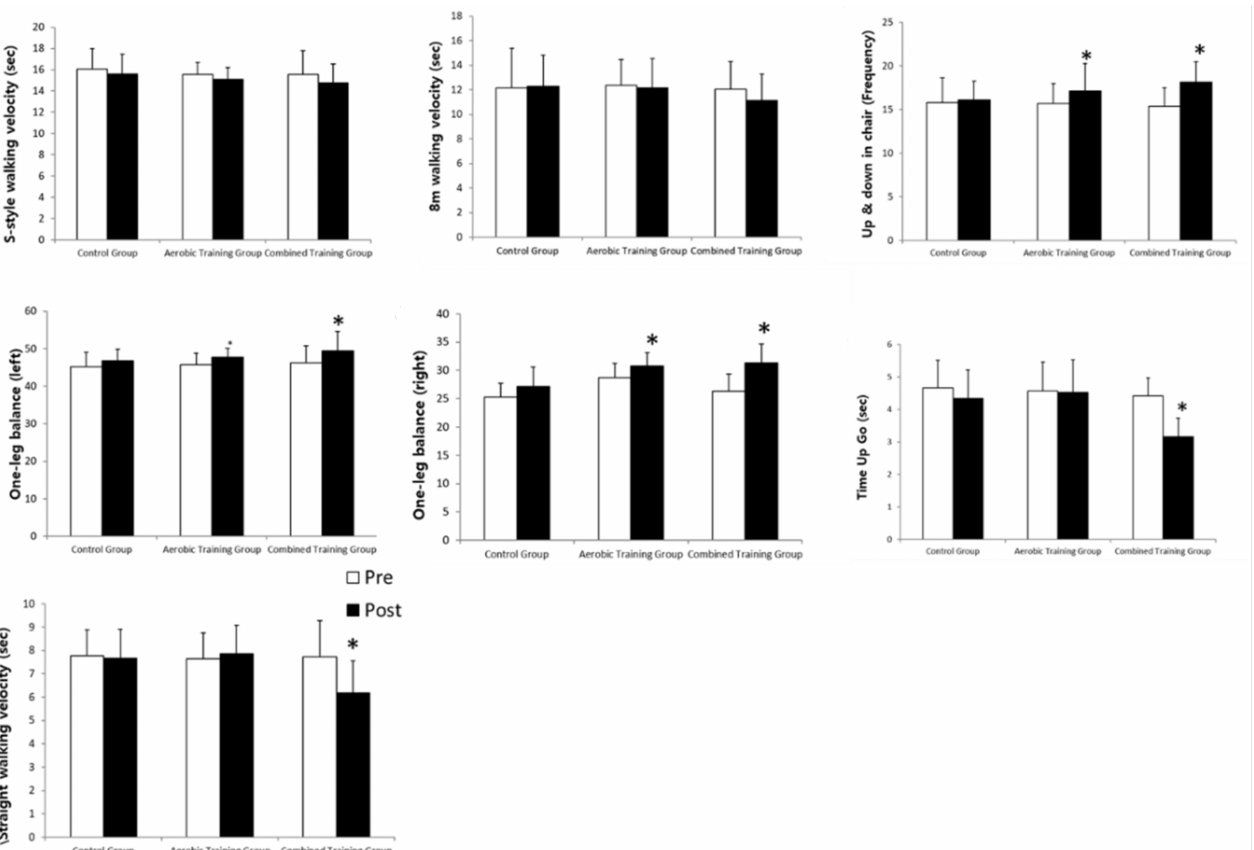
Figure 4. Change of gait ability-related physical fitness after 12 week exercise training. 2-way repeated ANOVA for group and time: S-style walking velocity, Group F 2,51 = 2.131 ( p > 0.05), Time F 1,51 = 4.671 ( p < 0.05), G × T F 2,51 = 8.357 ( p < 0.05); 8 m walking velocity, Group F 2,51 = 1.911 ( p > 0.05), Time F 1,51 = 2.112 ( p > 0.05), G × T F 2,51 = 1.196 ( p > 0.05); Up & down in chair, Group F 2,51 = 5.551 ( p < 0.05), Time F 1,51 = 5.981 ( p < 0.05), G × T F 2,51 = 9.531 ( p < 0.05); One-leg balance (Left), Group F 2,51 = 5.992 ( p < 0.05), Time F 1,51 = 4.857 ( p > 0.05), G × T F 2,51 = 10.115 ( p < 0.05); One-leg balance (Right), Group F 2,51 = 4.818 ( p < 0.05), Time F 1,51 = 5.919 ( p < 0.05), G × T F 2,51 = 10.627 ( p < 0.05); Time Up Go, Group F 2,51 = 5.171 ( p < 0.05), Time F 1,51 = 6.872 ( p < 0.05), G × T F 2,51 = 10.112 ( p < 0.05); Straight walking velocity Group F 2,51 = 4.892 ( p < 0.05), Time F 1,51 = 5.117 ( p < 0.05), G × T F 2,51 = 8.991 ( p < 0.05). *: p < 0.05 vs.